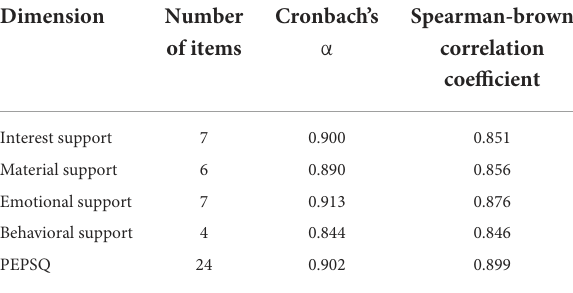
TABLE 7 Questionnaire dimensions and reliability